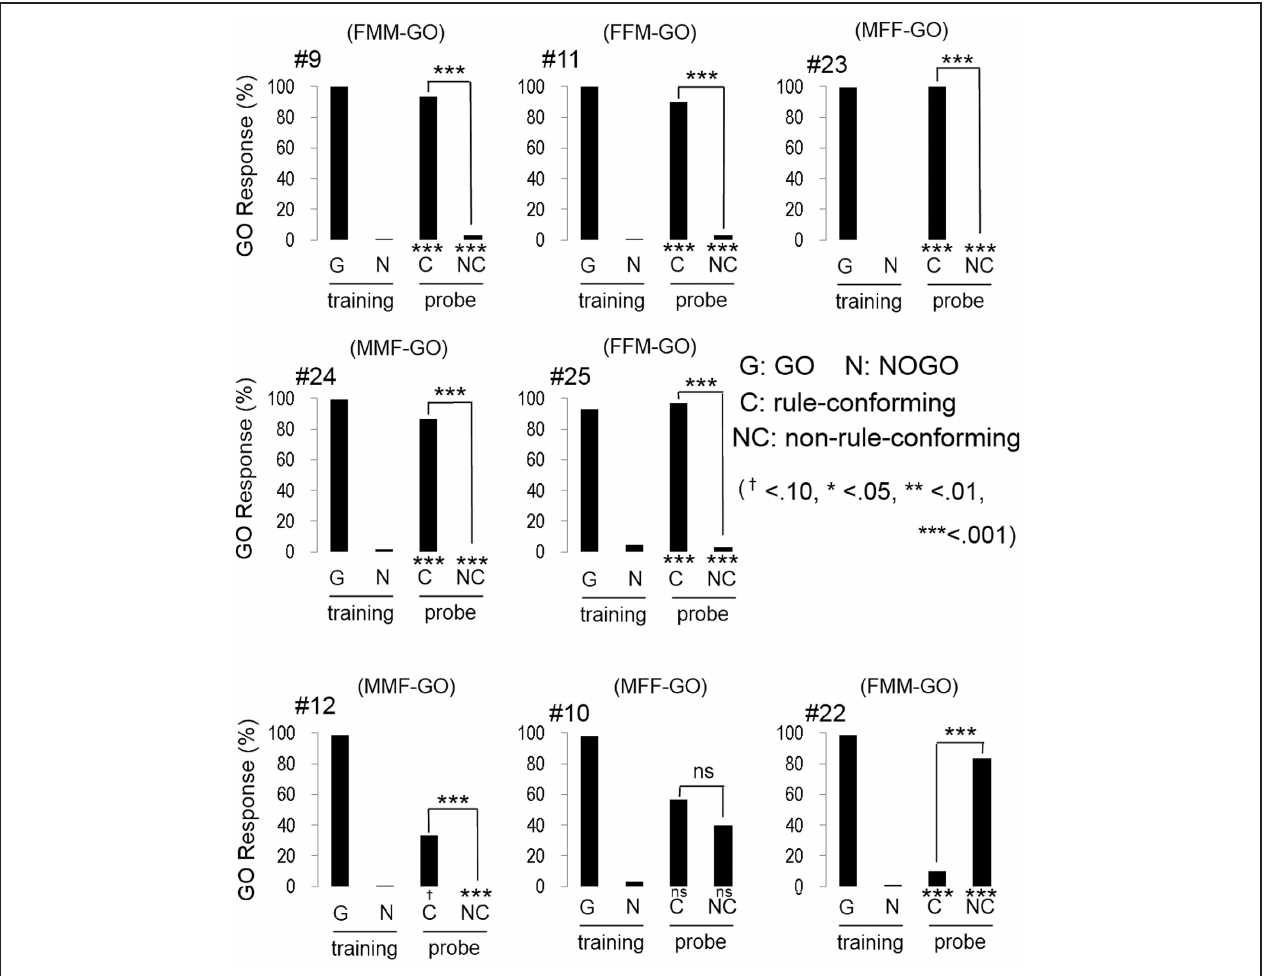
to those 5 participants, the bias to GO response for the probe stimuli was not found. Participant #10 showed unsystematic responses to the probe stimuli. The response pattern of #22 is similar to the response of birds #2, #5, and